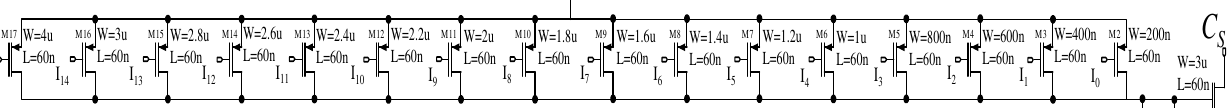
Figure 3. ( a ) Schematic of delay cell, ( b ) Block diagram of the ring oscillator [7].